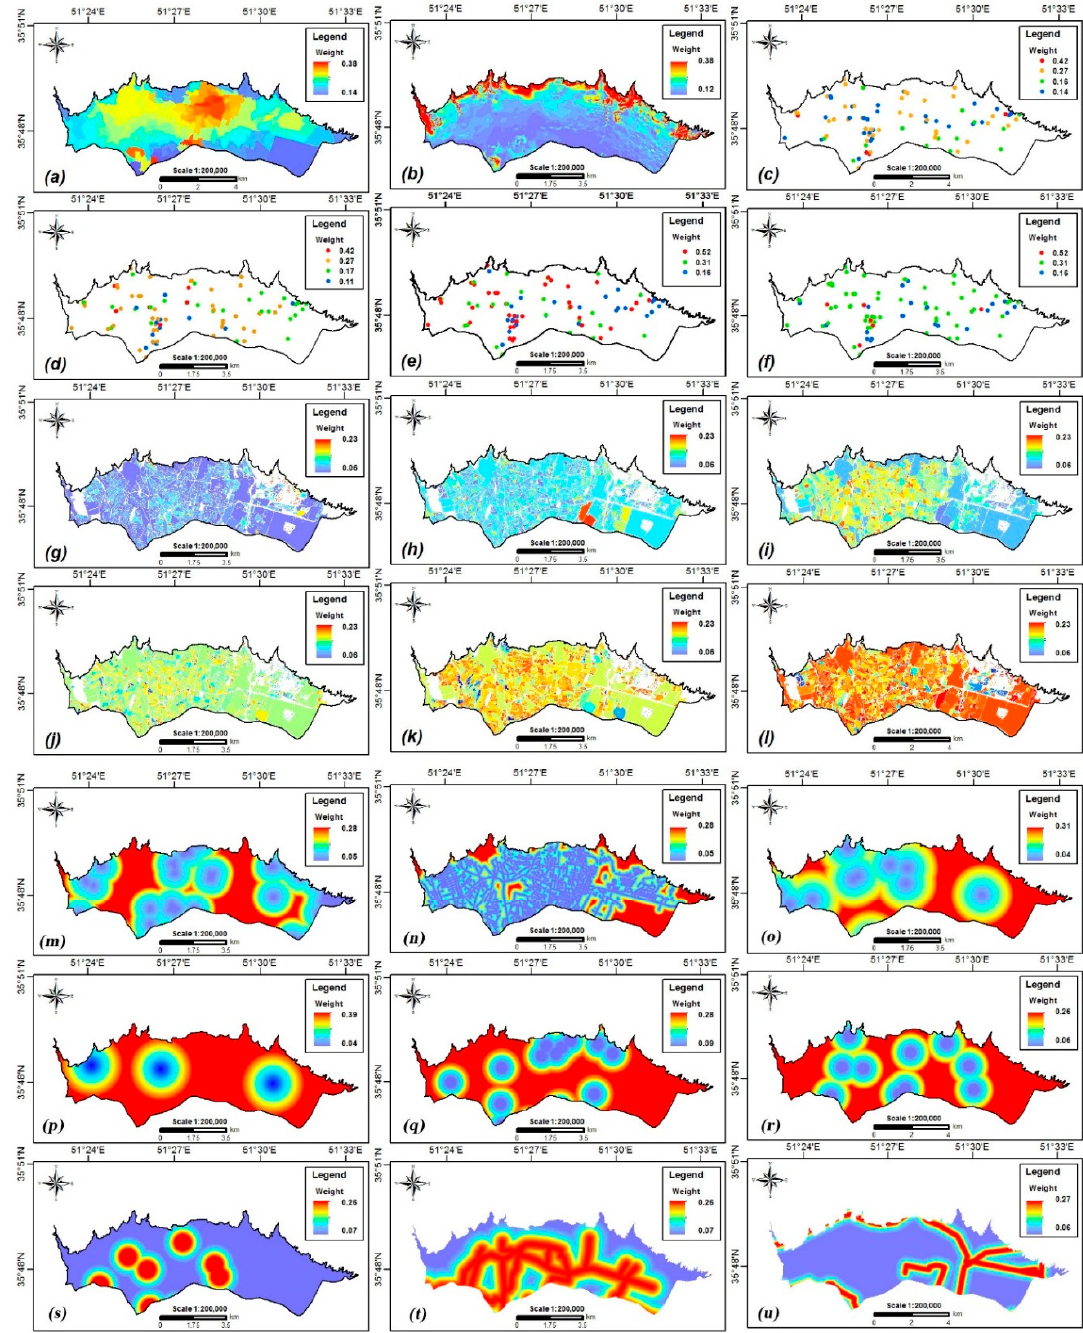
Figure 4. SEVUCAS input data: ( a ) peak ground acceleration, ( b ) slope, ( c ) construction materials of structures, ( d ) age of construction, ( e ) structure quality, ( f ) seismic resonance coefficient of structures, ( g ) population density, ( h ) children population density, ( i ) elderly population density, ( j ) female population density, ( k ) population level of education density, and ( l ) population employment status density, Distance to: ( m ) open spaces, ( n ) road network, ( o ) police stations, ( p ) fire stations, ( q ) hospital, ( r ) disaster management centers, ( s ) gas stations, ( t ) gas pipelines, and ( u ) high-voltage electrical power transmission lines.